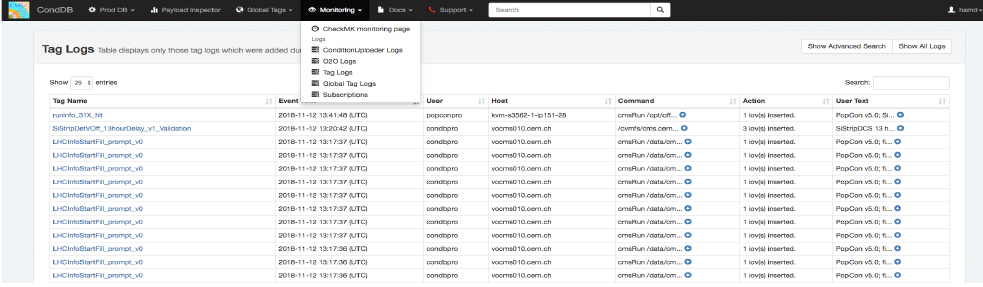
Figure 2. CmsDbBrowser Monitoring